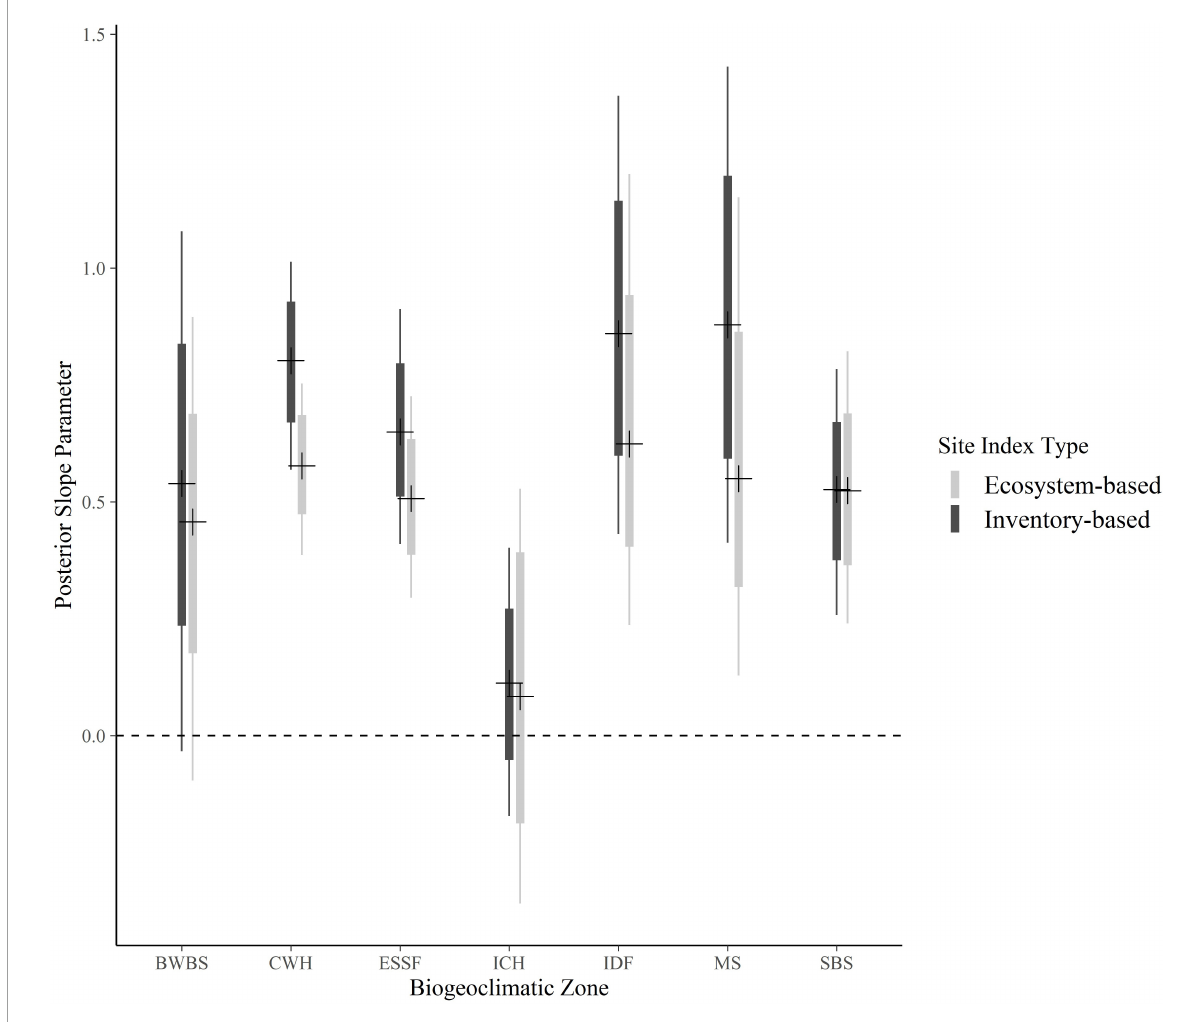
FIGURE1 Relationship between site index and measured tree height by biogeoclimatic zone in 1,497 ground plots across BC. Crosses represent the median slope and bars show quartiles and 90% credible intervals. BWBS P = 0.3; CWH P = 0.006; ESSF P = 0.12; ICH P = 0.59; IDF P = 0.15; MS P = 0.11; SBS P = 0.26. Biogeoclimatic zones: BWBS, boreal white and black spruce; CWH, coastal western hemlock; ESSF, Engelmann spruce–subalpine fir; ICH, interior cedar hemlock; IDF, interior Douglas-fir; MS, Montane spruce; SBS, sub-boreal